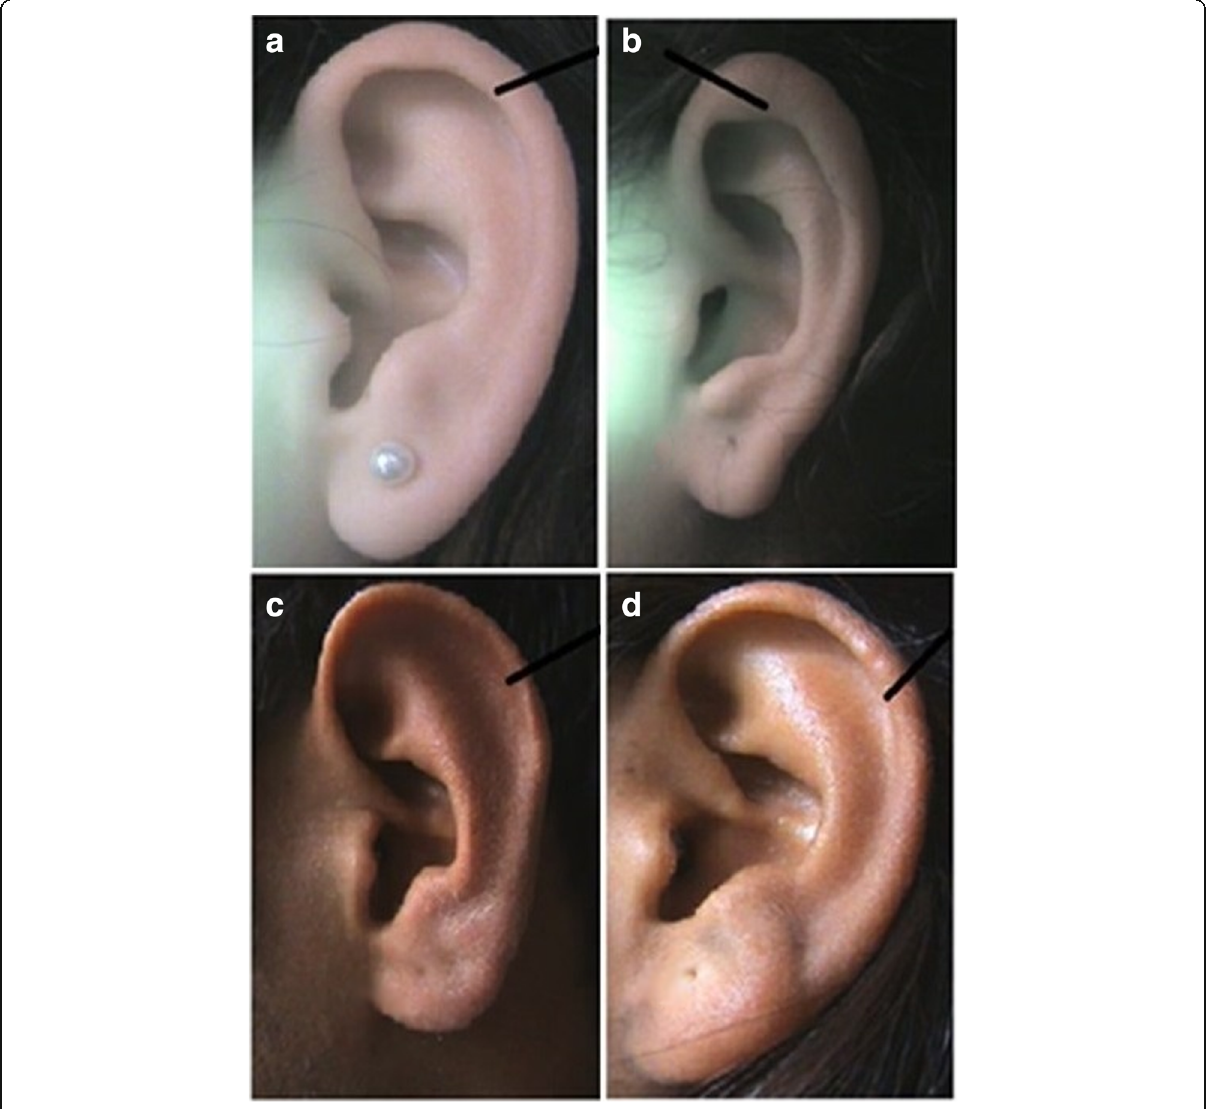
Fig. 3 Photographs showing the different forms of the helix. a Normally rolled. b Wide covering scapha. c Flat. d Concave